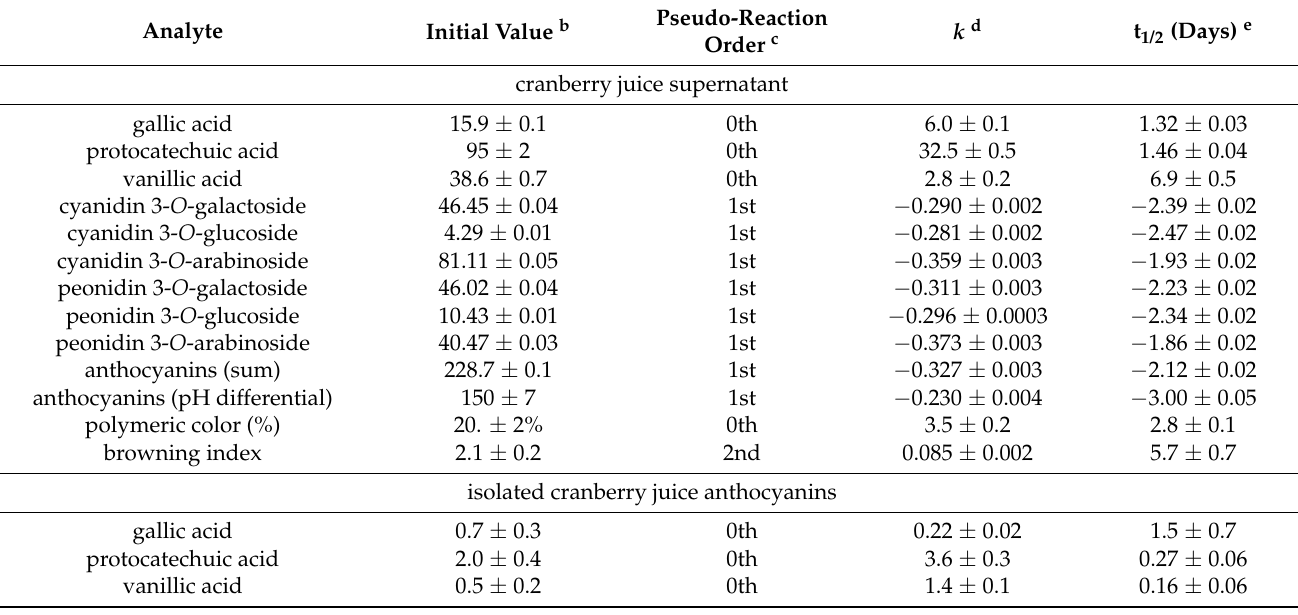
Table 1. Polyphenol content of cranberry juice supernatant or isolated cranberry juice anthocyanins in buffer over 10 days accelerated aging at 50 ◦ C a